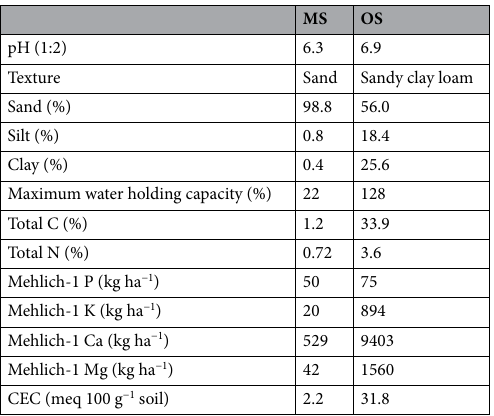
Table 3. Initial physico-chemical properties of mineral (MS) and organic (OS)